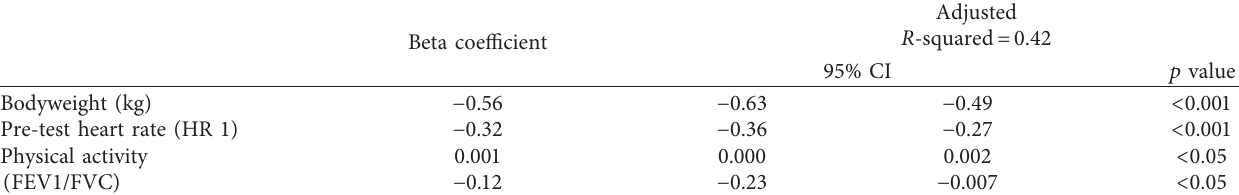
2max with compounding